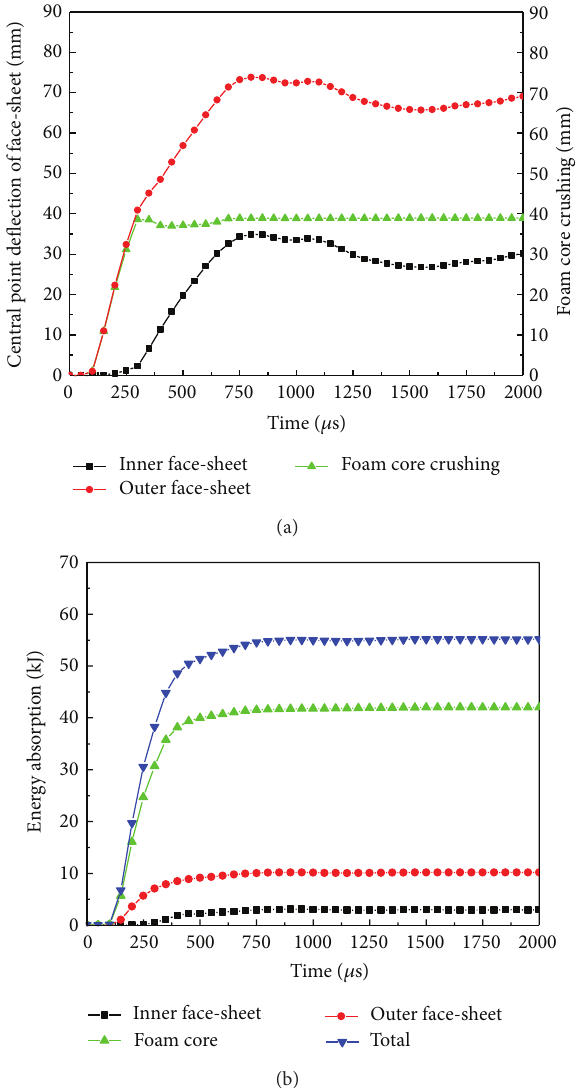
Figure 6: Time histories of (a) central deformation of face-sheets and foam core crushing and (b) energy absorption of the curved sandwich panel under blast loading.